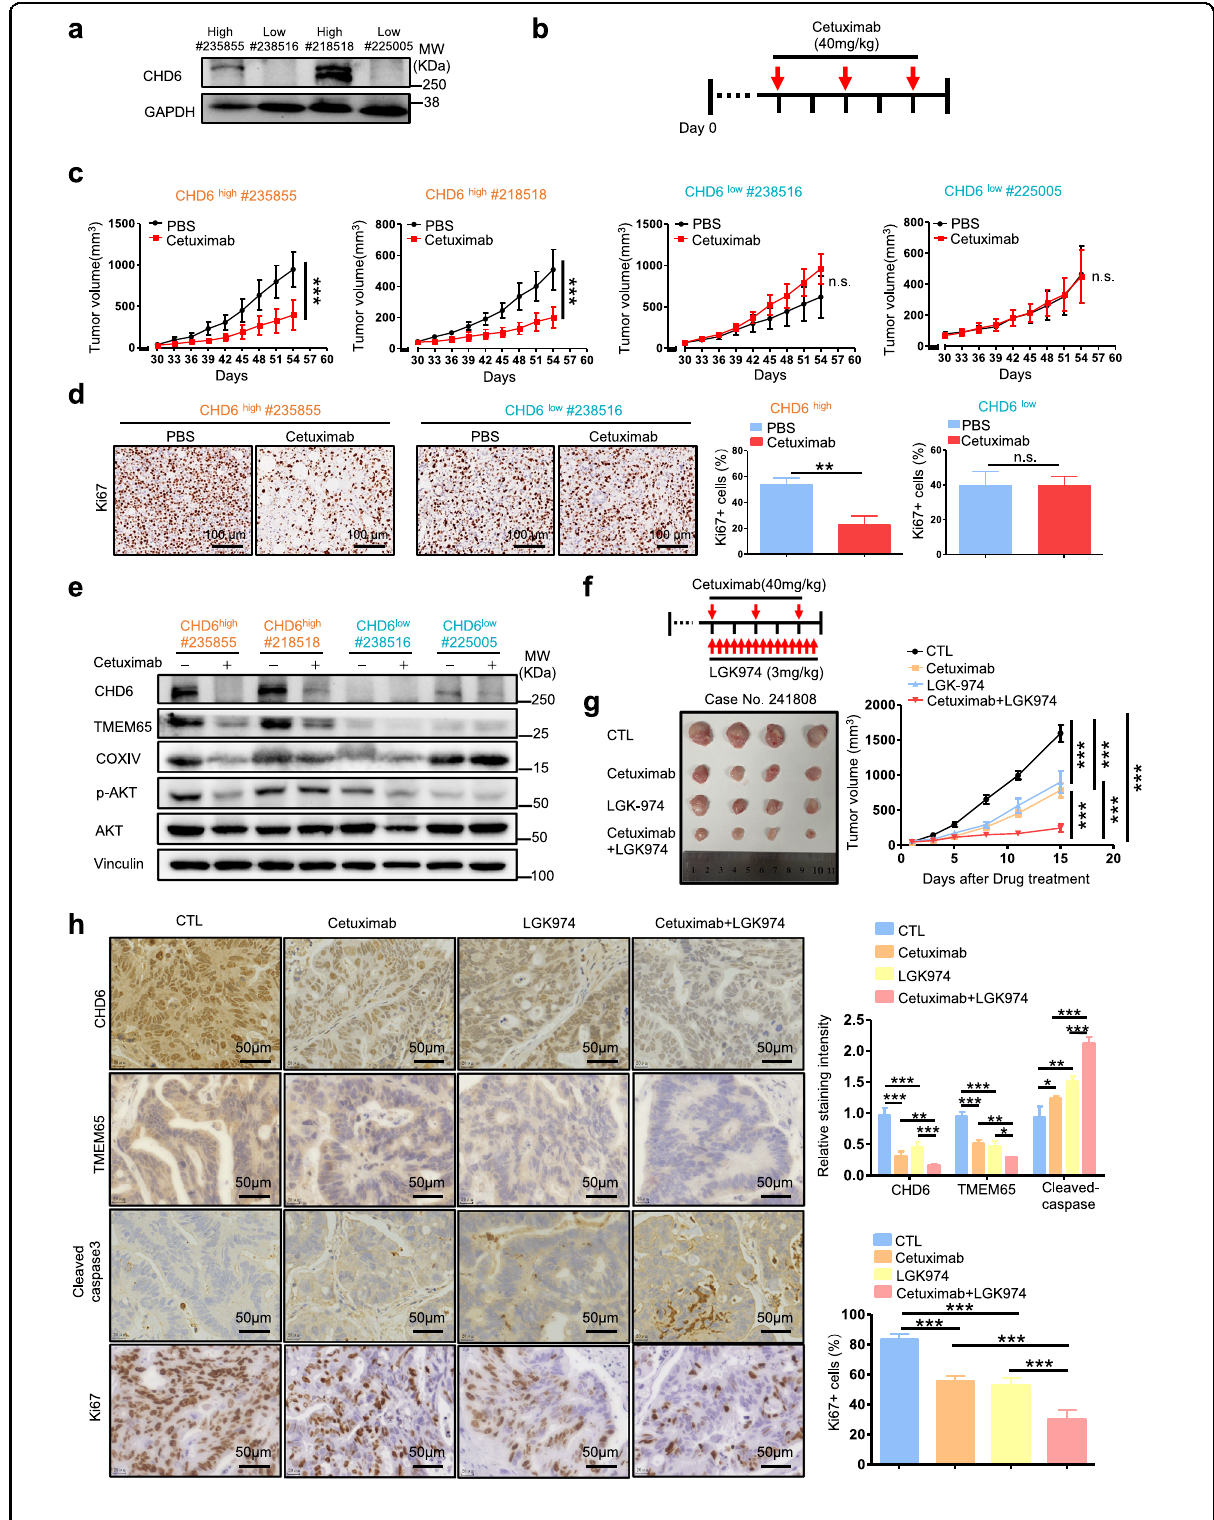
Fig. 8 (See legend on next